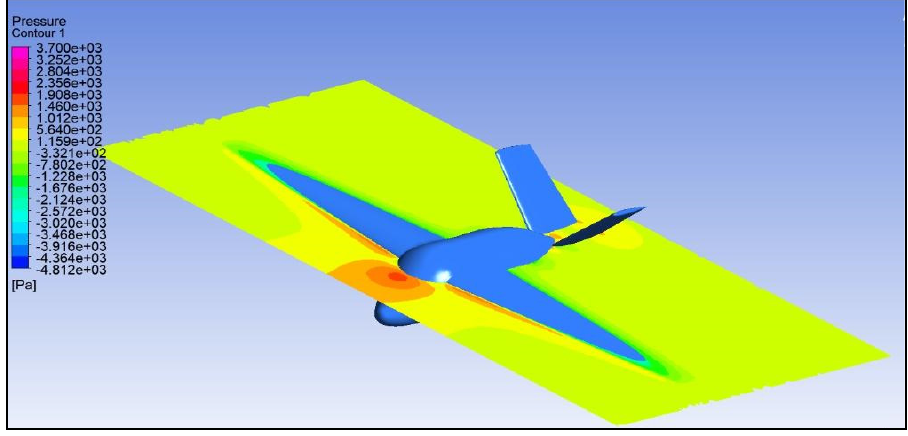
Figure 29. Static pressure contour at plane XY.